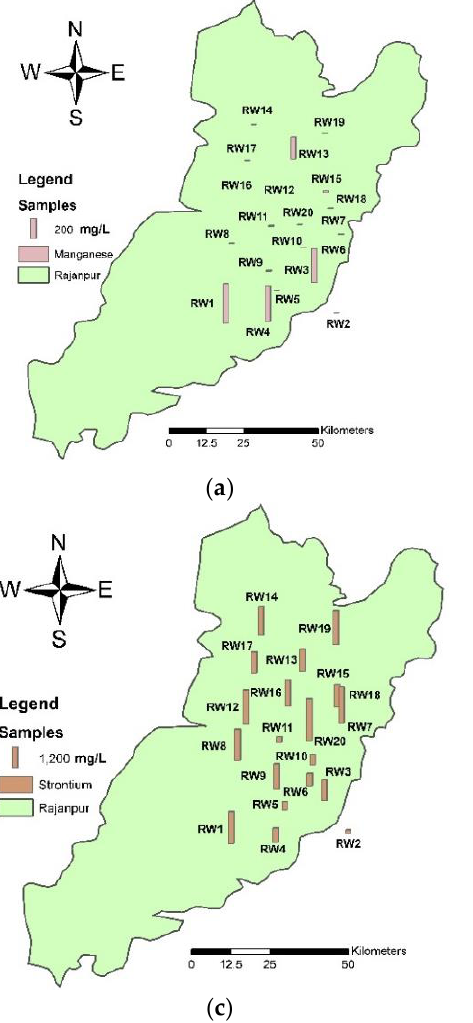
Figure 4. Spatial distribution maps of ( a ) strontium, ( b ) arsenic, ( c ) manganese, and ( d ) molybdenum showing the concentration of elements at the location sites in the study area of Rajanpur.